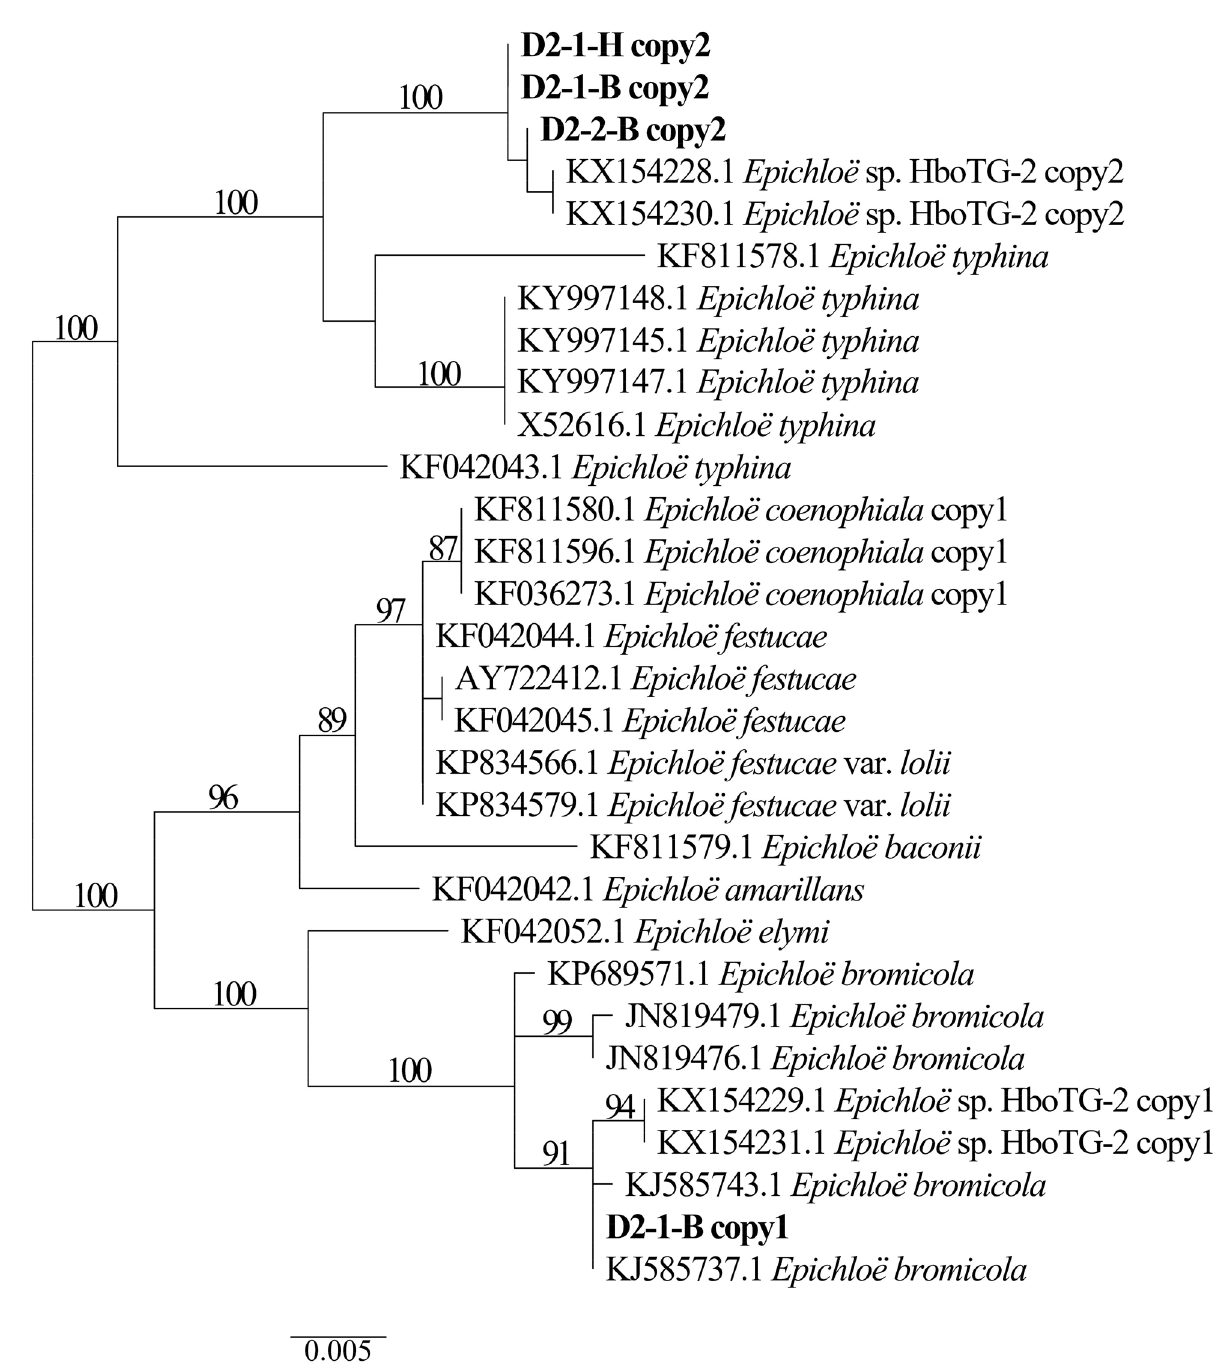
Figure 3. Molecular phylogeny derived from maximum likelihood (substitution model TNe + G4) analysis of the tubB gene from representative Epichloë species and copies of the hybridized endophytes isolated from H. bogdanii